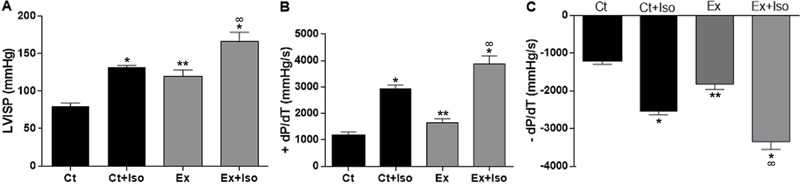
Effect of β-adrenergic activation by isoproterenol [Iso (100 μL, 10 μM, in
bolus)] in the Langendorff apparatus on (A) left ventricular
isovolumetric systolic pressure (LVISP), (B) positive first
time derivative (+dP/dt), and (C) negative first time
derivative (−dP/dt) from control (Ct, n=6) and exercised (Ex, n=6)
spontaneously hypertensive rats (SHR). Results are reported as means±SE.
*P<0.05, vs baseline condition; **P<0.05
vs Ct, ∞P<0.05 vs Ct+Iso (one-way
ANOVA).